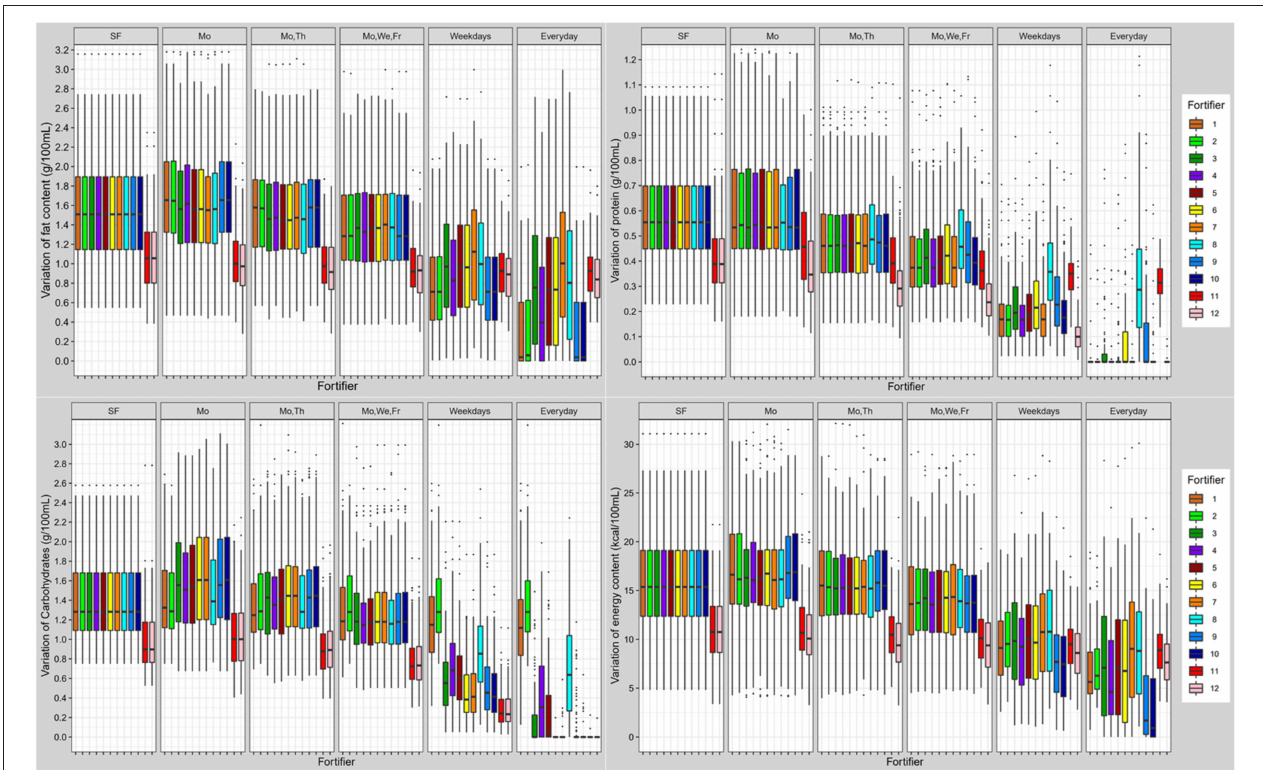
FIGURE 7 | Variation of macronutrient (fat, protein, carbohydrates) and energy content in fortified breast milk using 12 fortifiers with different schedules for milk analysis. Boxplots show the distribution of quantile distances (Q 0.1 -Q 0.9 ) of n = 103 subjects (SF, standard fortification; Mo, Monday; We, Wednesday; Th, Thursday; Fr,